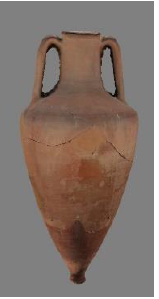
Figure 6. 3D model of Chian amphora